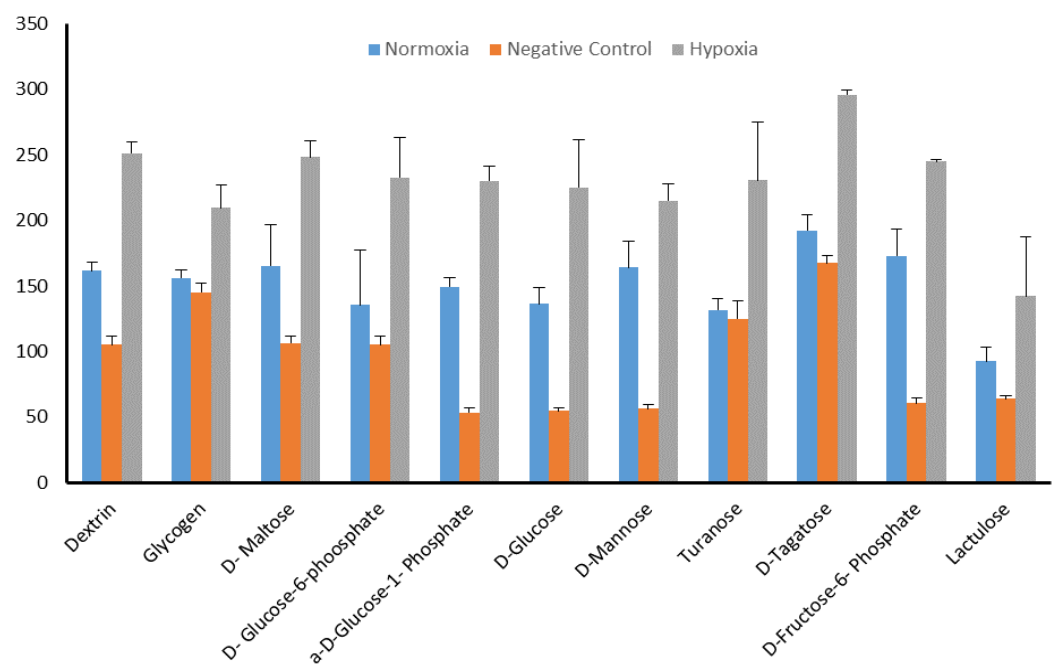
Figure 6. Chemical-substrate utilization after 24 h incubation with MA mix dye in OmniLog reader. Referring to heat-map data, only 11 types of chemical substrates were found that were significantly increased in hypoxia compared to normoxia (control) and negative control (without cells). Graph visualized by Excel, and analysis performed by GraphPad Prism 6 using one-way ANOVA. p -value < 0.05 considered significant. The Hypoxia group, compared to negative control group (without cells), was significant in 11 substrates. Y axis shows the OmniLog value (color density units) that reflected metabolism intensity in cells.